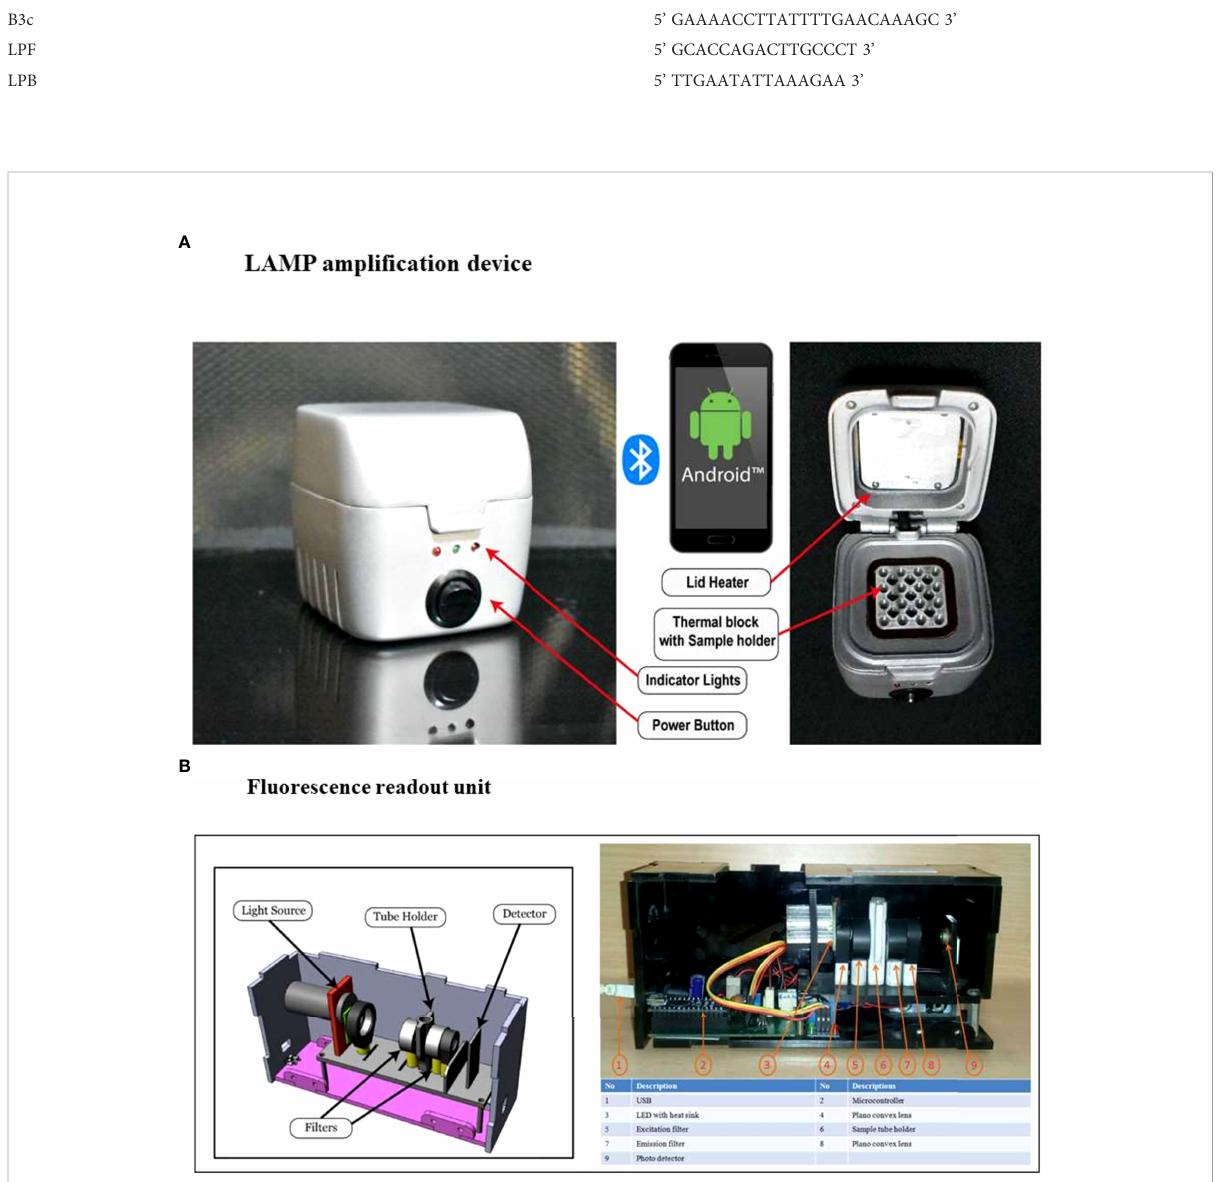
FIGURE 1 Components of the portable LAMP device and fl uorescence readout unit. (A) The LAMP device has 16 sample wells, a heating thermal block and a lid which features a heating element to prevent condensation during the ampli fi cation process. Three indicator lights in the front panel: red to show the operation status of system power, orange to show the Bluetooth connection, and green to display the ampli fi cation reaction process, are present. The reaction settings are set using a mobile application that connects the LAMP device to a smartphone. The app has a simple graphical user interface to set the temperature and time for the reaction and shows the real-time temperature of the block. (B) The fl uorescence readout unit has an integrated LED light source, optical fi lters (excitation and emission fi lters suitable for SYBR Gold), a sample vial holder, a photodiode, and an electronic driving circuit. The samples are mixed with SYBR Gold and placed in the sample holder. When the measurement is initiated the LED and photodiode are synchronized to read the fl uorescence emission from the sample. The system measures the fl uorescence levels at an interval of 3 seconds (1 second on and 2 seconds off). The data is logged into a fi le where it can be used for further analysis (Puri et al., 2021).